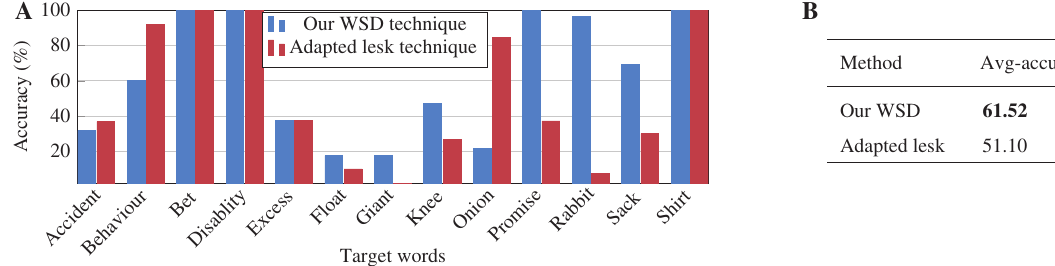
Figure 3: The obtained results of assessing the quality of our WSD method that show (A) the Accuracy Obtained by our WSD Method and the Adapted Lesk Algorithm on 13 Noun Target Words. (B) Average Accuracy for all the Target Words, indicating a considerable improvement in result (shown in bold) compared to the Adapted lesk method.